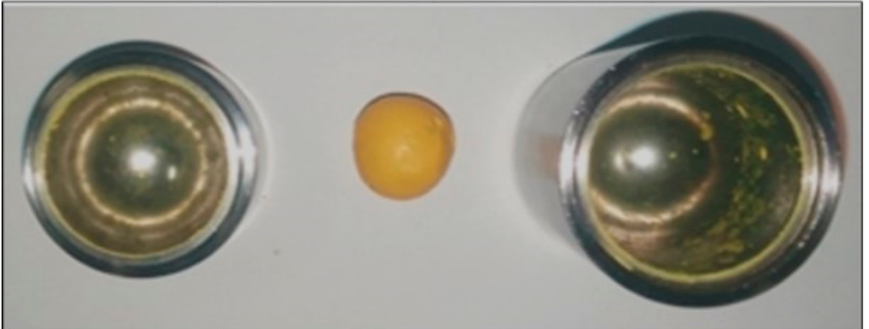
Figure 2. The cohesive state on the ball. Photograph of the steel milling ball with the cohesive rubber-like coating of the reaction mixture (centre) with the ball mill jar (left) and lid (right) almost free of material.